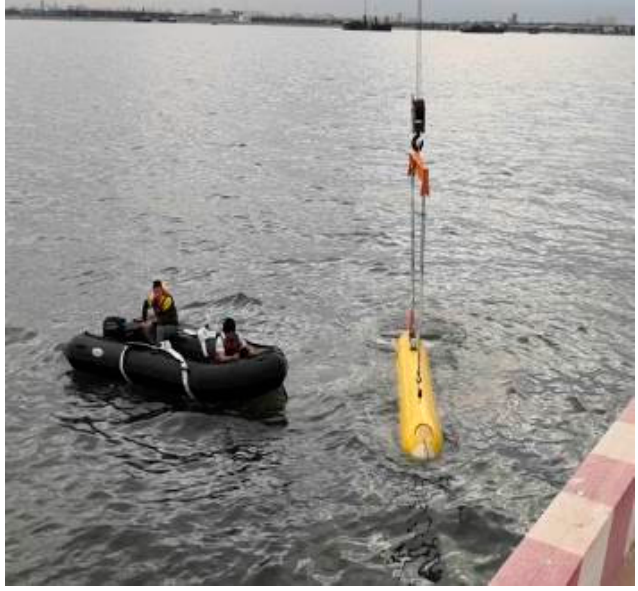
Figure 14. AUV offshore deployment.